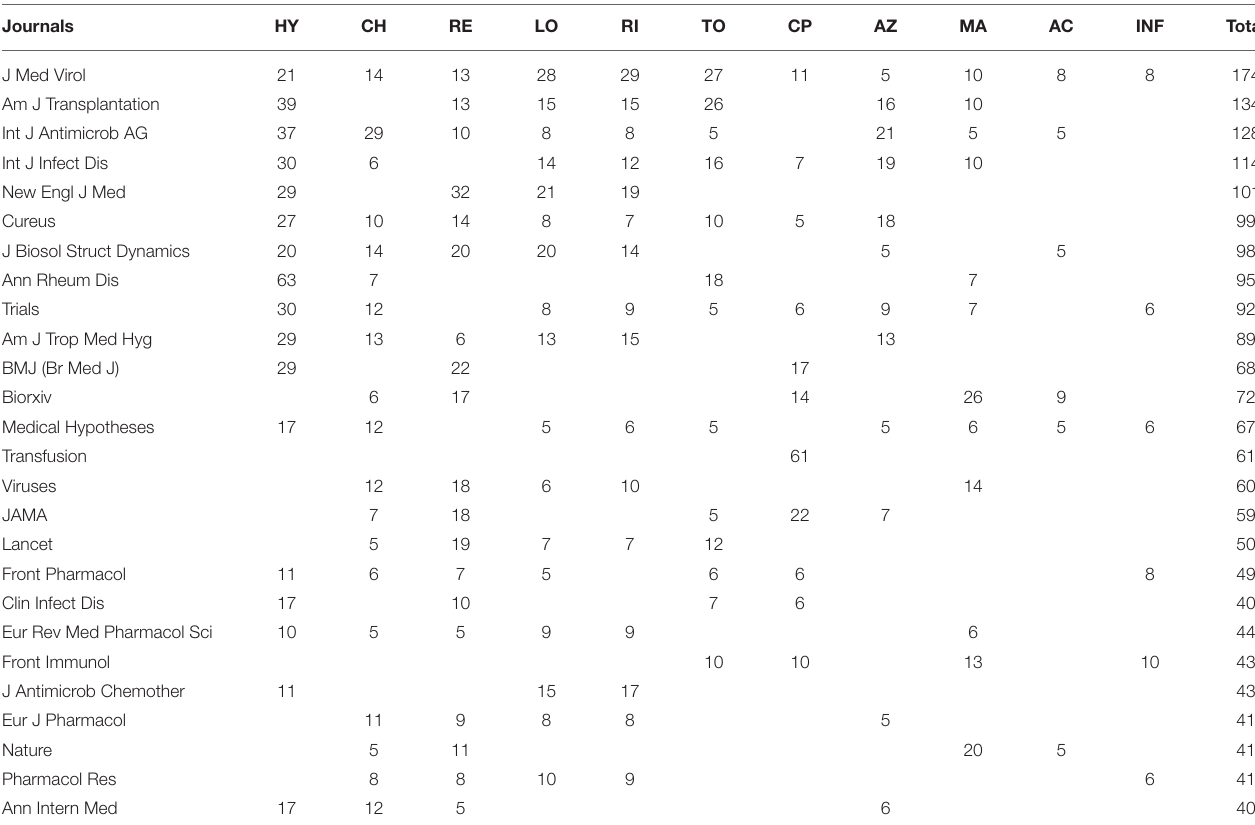
TABLE 4 | Production in terms of number of studies by journal and drug ( ≥